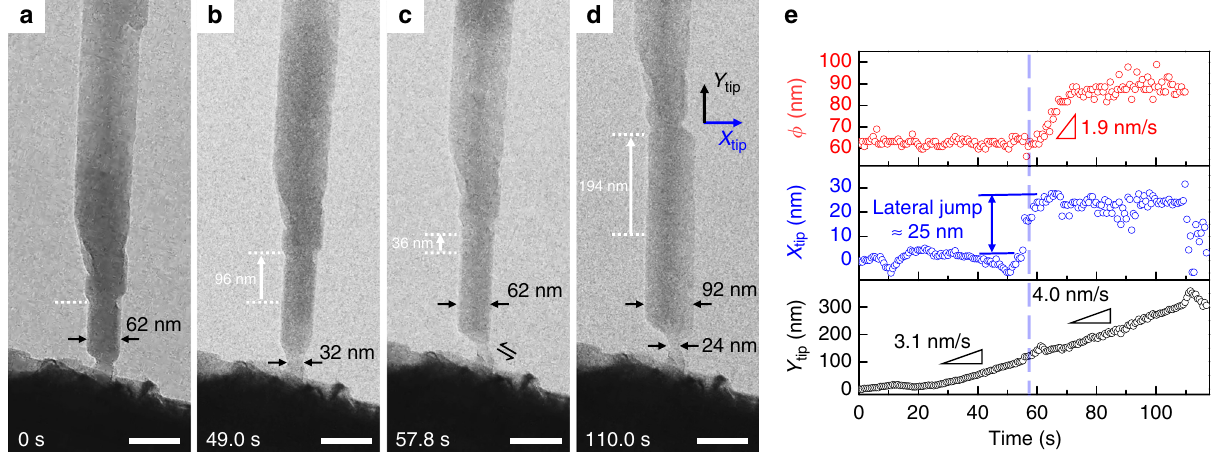
Fig. 4 Tip movement to control the nanowire growth. a , b During the period of uniform growth, the length of nanowire increased by 96 nm while the apparent diameter ( ∅ ) remained unchanged. c , d at 57.8 s, a lateral jump of ~25 nm leftward occurred to the tip. After the jump, the nanowire showed increase in both length and ∅ . e Plot of ∅ and the change of tip position in the pulling direction ( Y tip ) and lateral direction ( X tip ) as a function of time. Scale bars, 100 After developing the shape as depicted by the dashed black line at 51.5 s in Fig. 3b, tooth #1 and #2 did not show visible growth from 51.5 to 70.5 s, while in this period, tooth #3 nucleated and